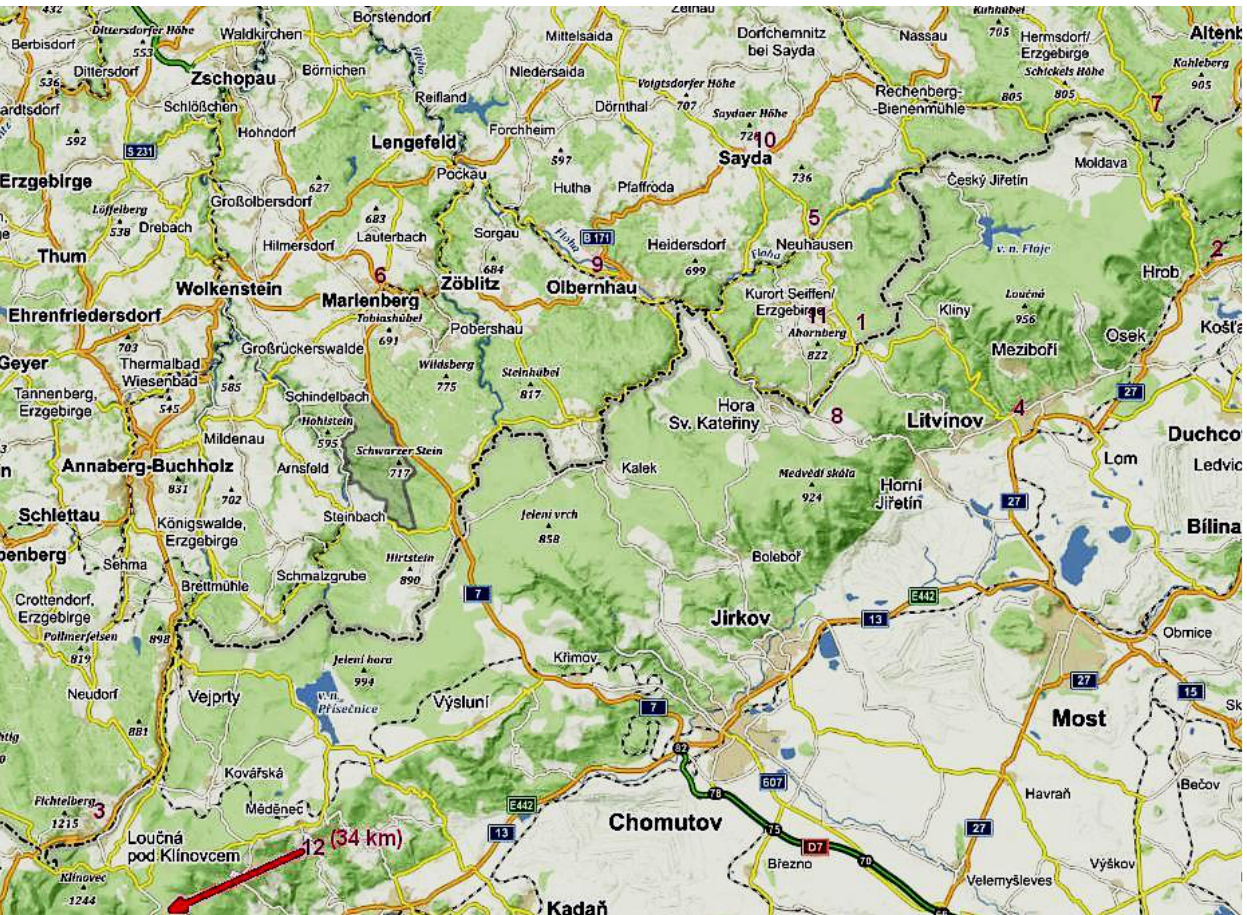
Figure 3. Canister sampling sites. Numbers in red refer to individual sites: 1 — Deutscheinsiedel, 2 — 2—H á j u Duchcova, 3—Kühnhaide, 4—Litv í nov, 5—Neuhausen, 6—Marienberg, Háj u Duchcova, 3 — Kühnhaide, 4 — Litvínov, 5 — Neuhausen, 6 — Marienberg, 7 — Neurehefeld, 8 — Nová Ves v Horách, 9 — Olbernhau, 10 — Sayda, 11 — Seiffen, and 12 —Vřesová . (Background map: